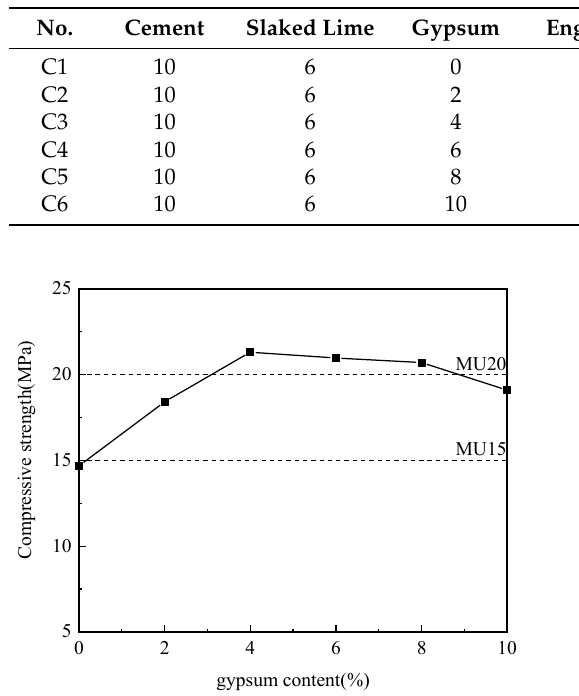
Table 4. Gypsum and aluminum ash mix design. (wt.%).